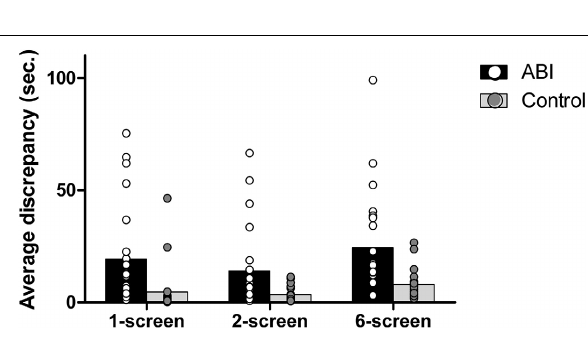
FIGURE 3 | Average discrepancy in